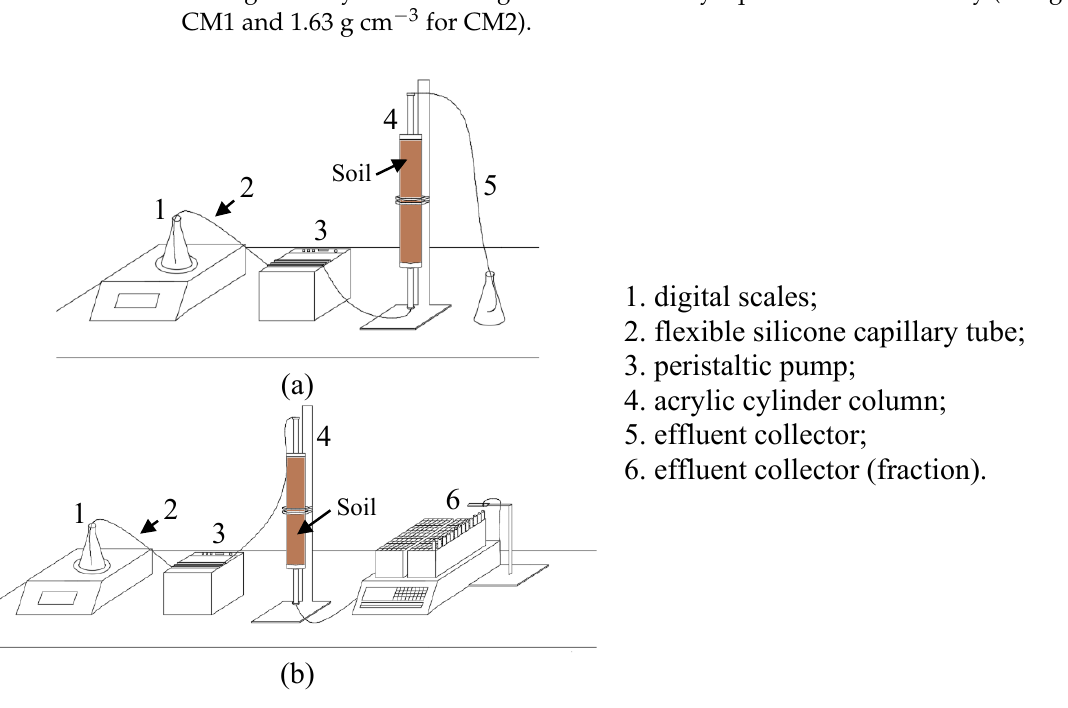
Figure 2. Schematic design of the fixed bed column used for saturation of the soil column in upward flow mode ( a ) and displacement of KBr and RB5 solutions in downward flow ( b ).